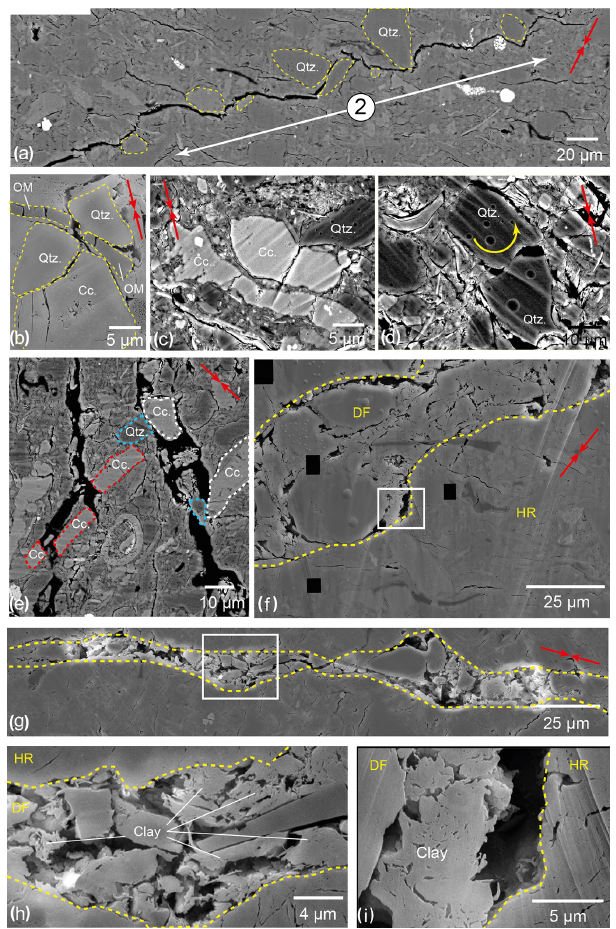
Figure 7. Detailed microstructures in sample COX-2MPa. (a) A fracture running parallel to the antithetic fractures and at the inter- faces between non-clay mineral and clay matrix. In (b) intragranular fractures are in calcite grain (Cc.) and transgranular fractures are in organic matter (OM), whereas in (c) transgranular fractures are in Cc. at impingement with quartz grain (Qtz.). (d) A broken quartz grain showing evidence for rotation of its broken fragments. (e) In- cipient of flow of broken non-clay minerals within the antithetic fractures indicated by red (Cc.), blue (Qtz.) and white (Cc.) dashed lines. (f) and (g) show parts of antithetic fractures displaying thick damaged fabrics made of broken grains and clay matrix fragments. (h) Details of the white box indicated in (g) . (i) Details of the white box indicated in (f) , showing the denser and deformed fabric of a part of the clay matrix squeezed between a quartz grain located in the damaged fabric and the boundary with the host rock. In (f) – (i) , the damaged fabric is related to a higher porosity in comparison to the host rock. In all micrographs, the orientation of the principal stress ( σ 1 ) is indicated by red arrows. The bedding is perpendicu- lar to σ 1 . Dashed yellow lines indicate the boundaries between the damaged fabric (DF) and the host rock (HR) and also some grain boundaries in (a) . Black squares in (f) are missing